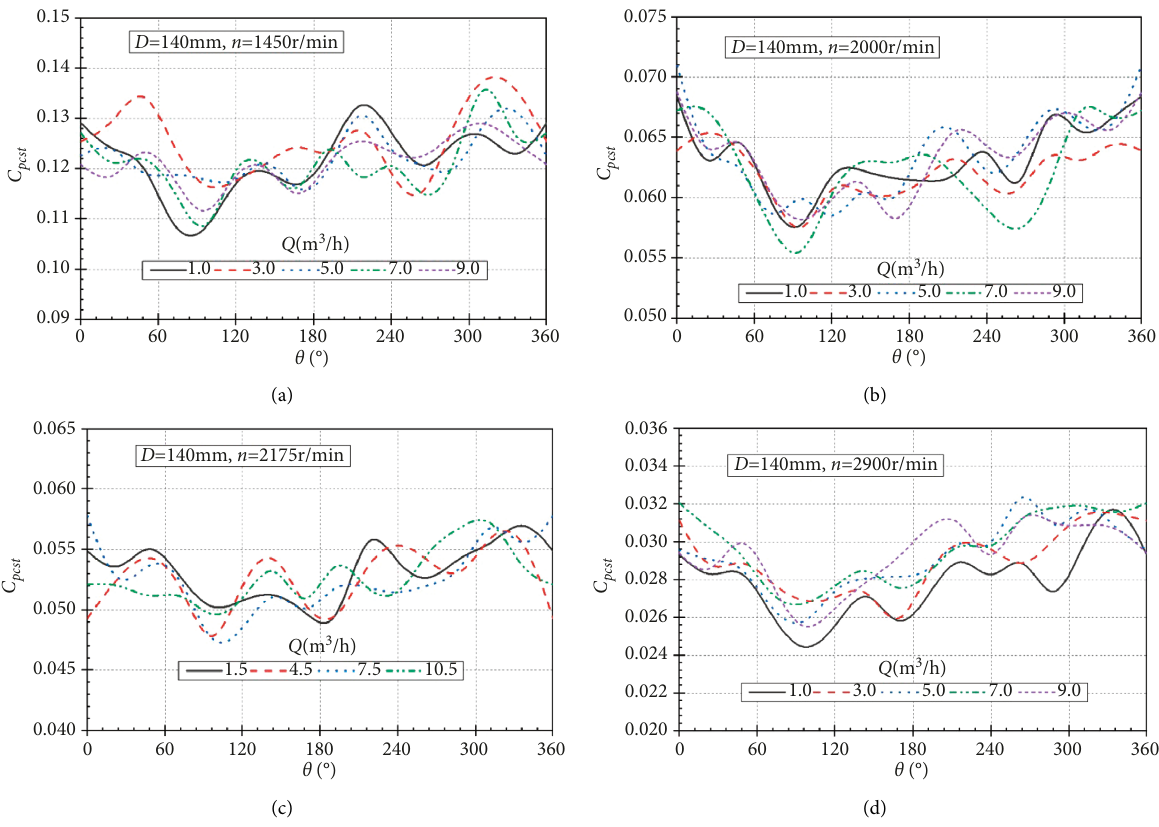
Figure 12: Pressure pulsation intensity of at the front wall of volute casing ( D � 140mm).